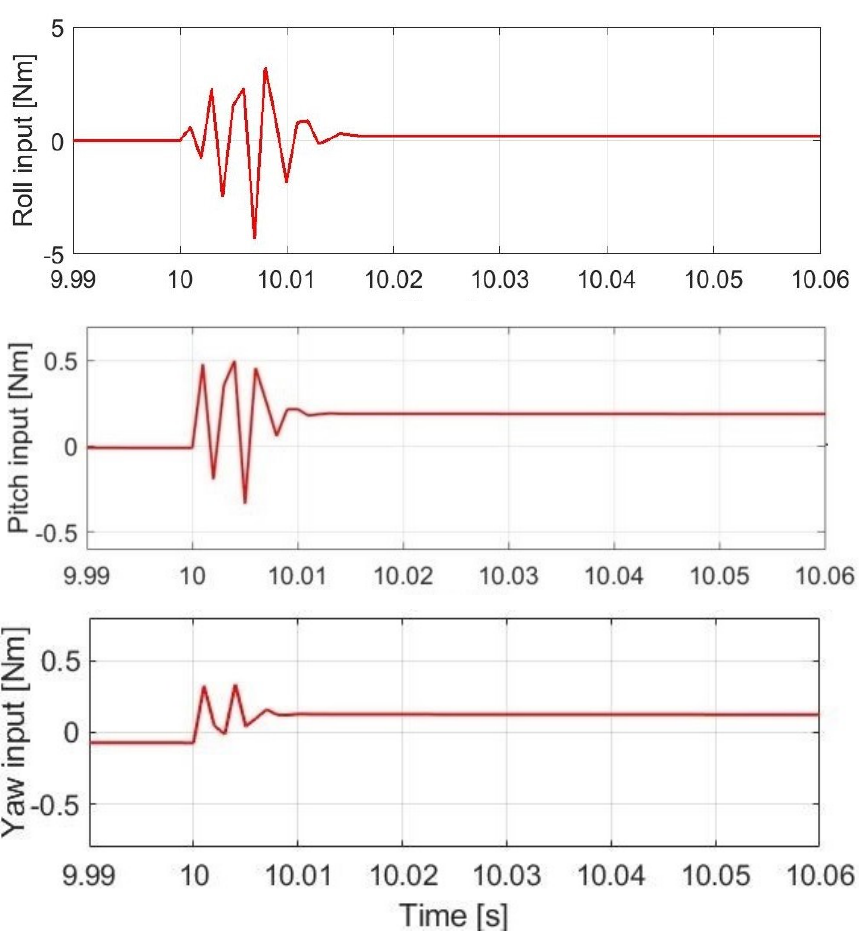
Figure 6. Control efforts in the presence of disturbances and uncertainties. To evaluate the effect of the proposed learning mechanism, the ITAE values were computed for ILSMC after each iteration with different values of λ . The results up to 15 iterations are presented in Figure 7. They indicate that the ITAE of the all three attitude angle errors quickly decreases and converges to zero after several iterations. To induce a fast system sliding mode, a higher rate of convergence must be selected. It can be seen in Figure 7 that this can be obtained when λ is close to one. In this work, λ = 0.9 was chosen to achieve the desired control